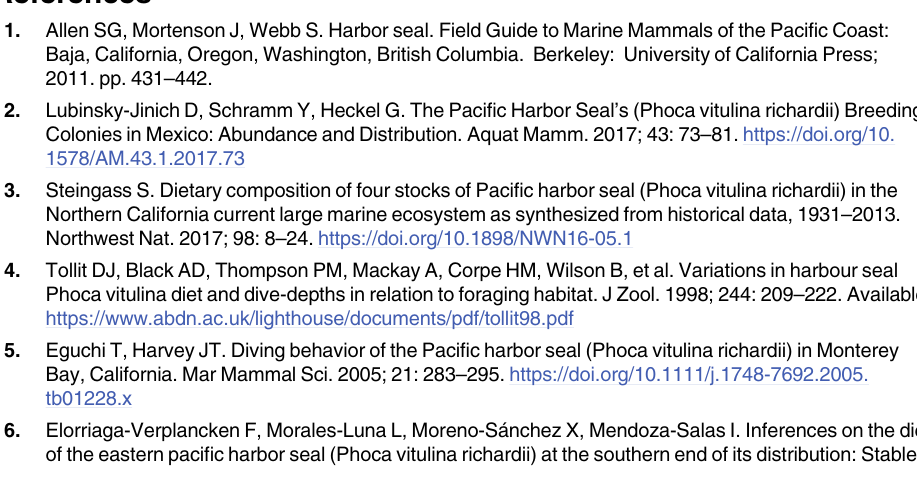
S6 Table. Core metabolism pathways found in all the harbor seal fecal samples. S7 Table. Spearman rank correlation results for diet and gut microbiota function and com- position. Correlations marked in red are significant at p <